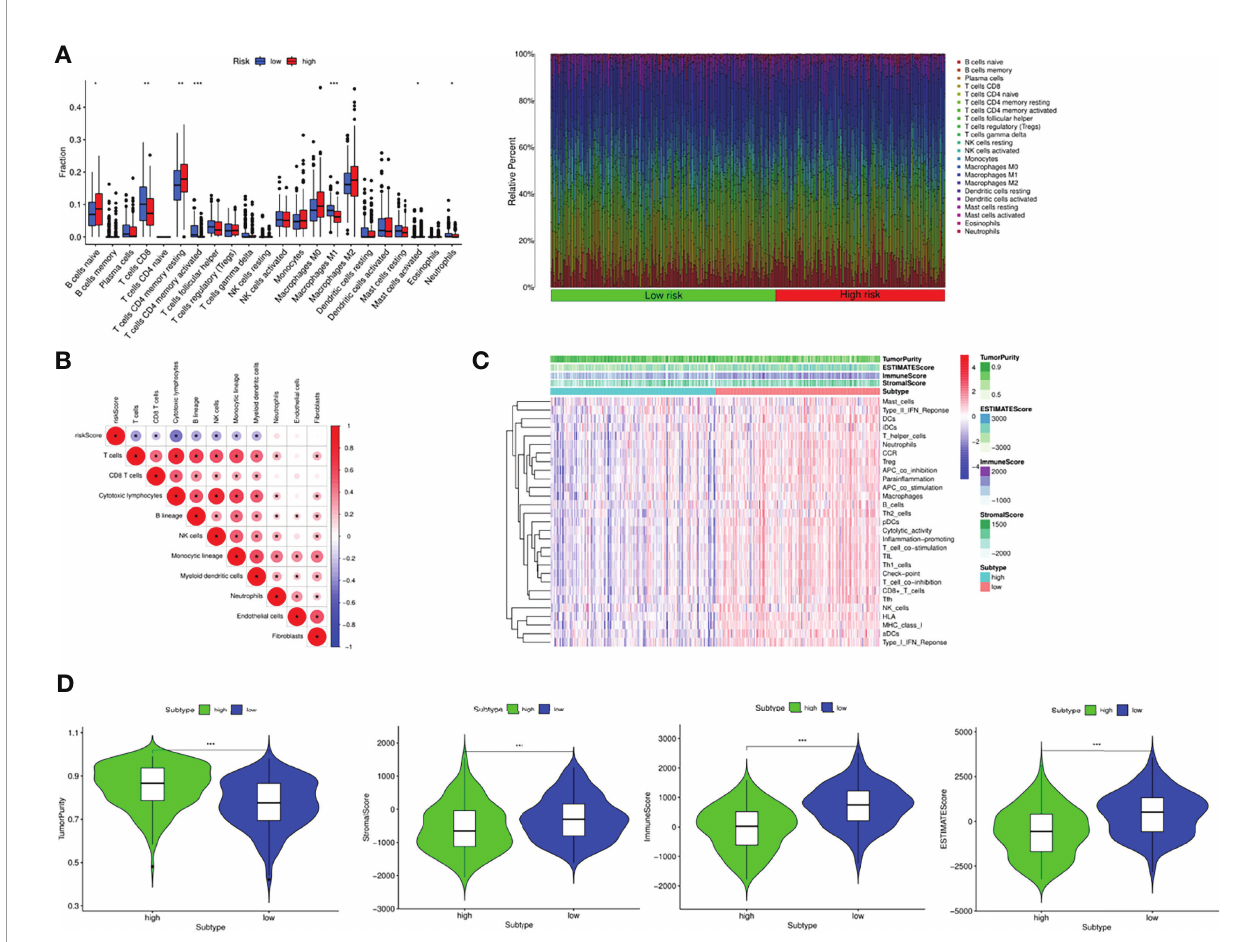
FIGURE 7 | Tumor immune landscape in OC. (A) Bar plot of 24 kinds of immune cells between high and low risk groups via CIBERSORT. (B) The correlation between immune cells and risk score. (C) Heatmap integrated by the immune scores and immune cells and functions. (D) Comparison of tumor purity, stromal score, immune score and ESTIMATE scores between the two groups. * P < 0.05, ** P < 0.01 and *** P <